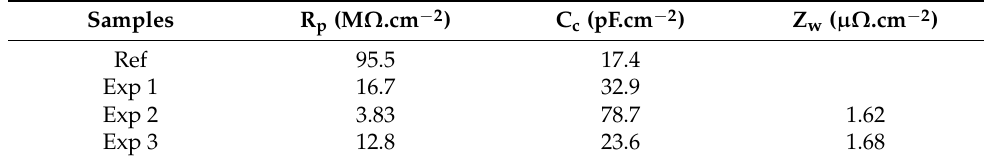
Table 7. EEC values for virgin and aged samples.